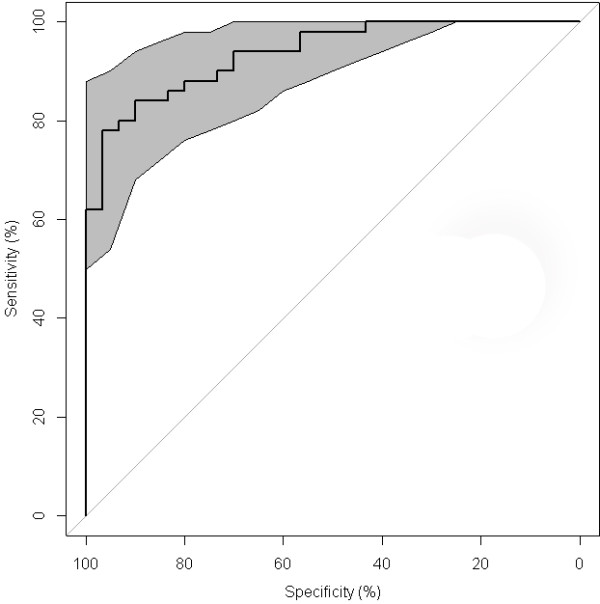
ROC curve for C/M ratio with 95% confidence interval. Taking in consideration the animals with thymus score 2, the best cut-off value of the C/M to discriminate treated and untreated samples resulted to be 0.93 (AUC 0.94; 95% CI 0.89-0.98).